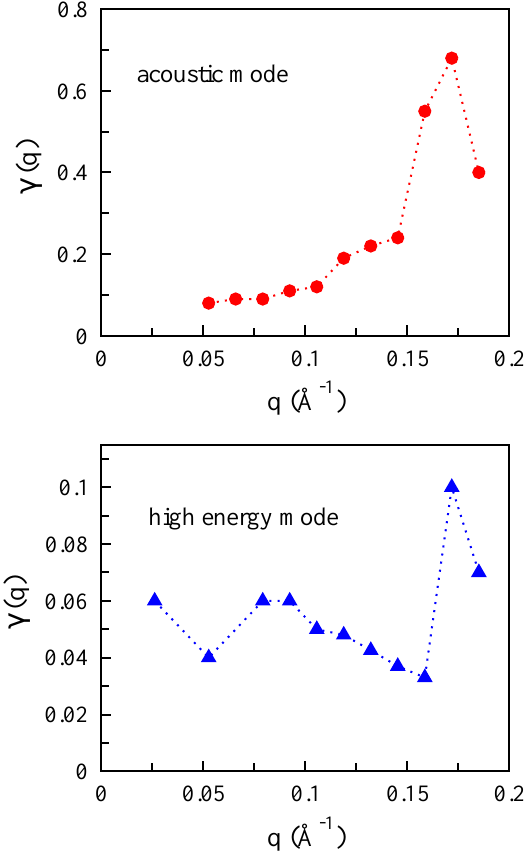
Figure 14. The damping parameter of plasmon modes in bilayer MoS 2 as a function of the momentum for n = 6.9 × 10 13 cm − 2 . Note that in order to have a well-defined plasmon mode, γ ( q ) / ω p ( q ) <<